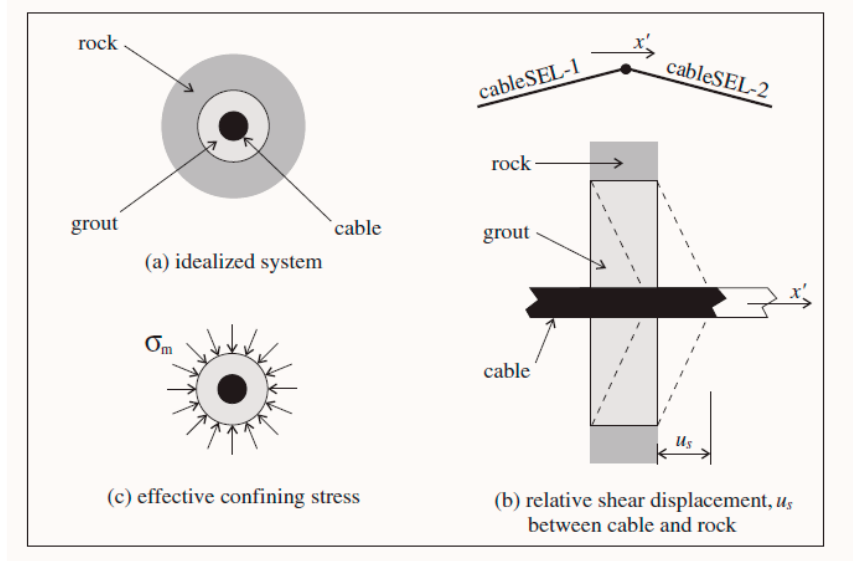
Figure 1. Stress of the anchor cable.